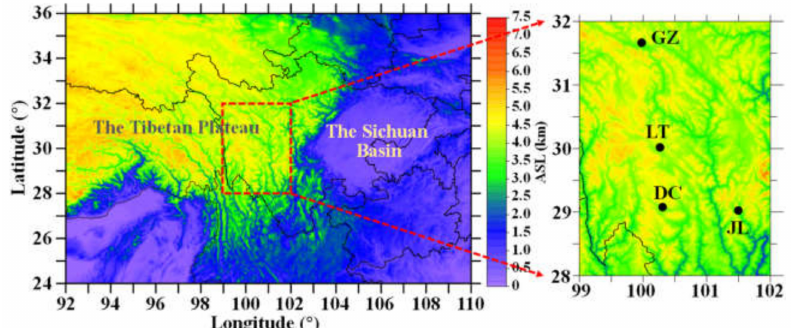
Figure 1. The geographic position and terrain of the four observation